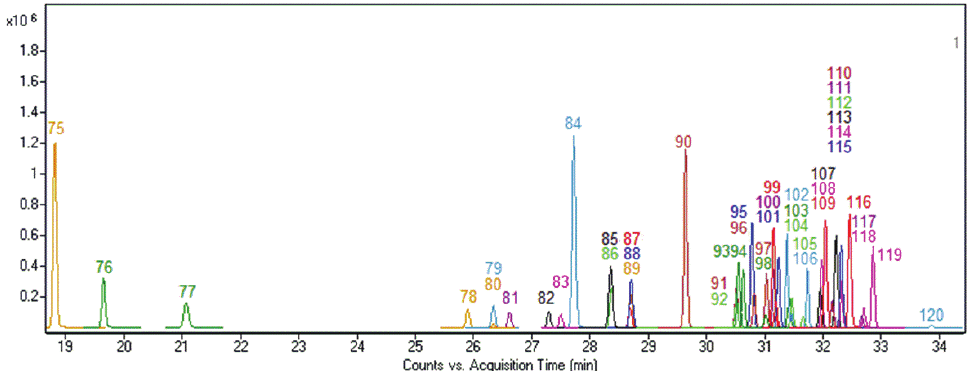
Figure 2. Chromatograms for the quantifier MRM transitions of synthetic cannabinoids compounds,